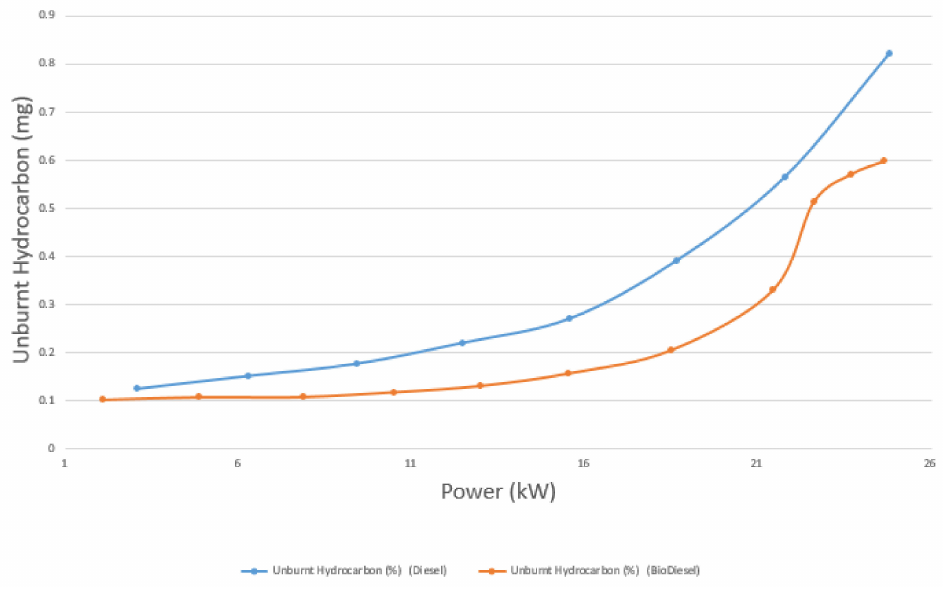
Figure 20. HC vs.